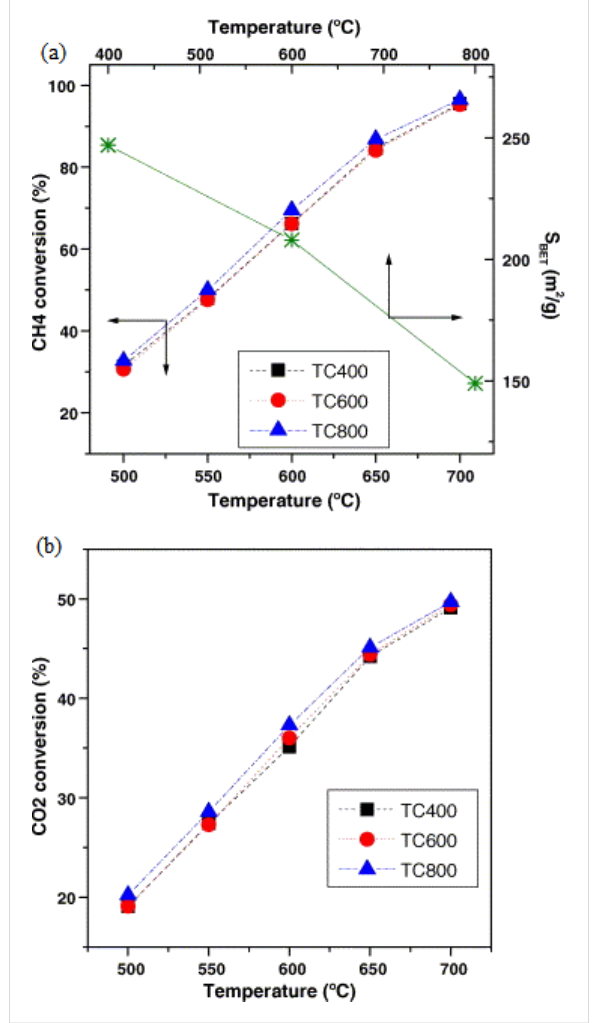
Figure 13: Conversion of methane (a) and carbon dioxide (b) on N55M11 calcined at different temperatures ( ■ ) 400 °C, ( ● ) 600 °C and ( ▲ ) 800 °C and reduced at 700 °C. S BET as a function of the calcina- tion temperature. Reprinted with permission from [92], copyright 2006